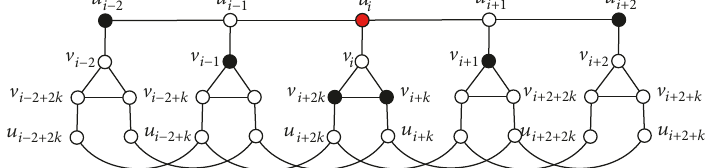
Figure 1: The set of black vertices is 𝑁 2 (𝑤) for 𝑤 = 𝑢 𝑖 .